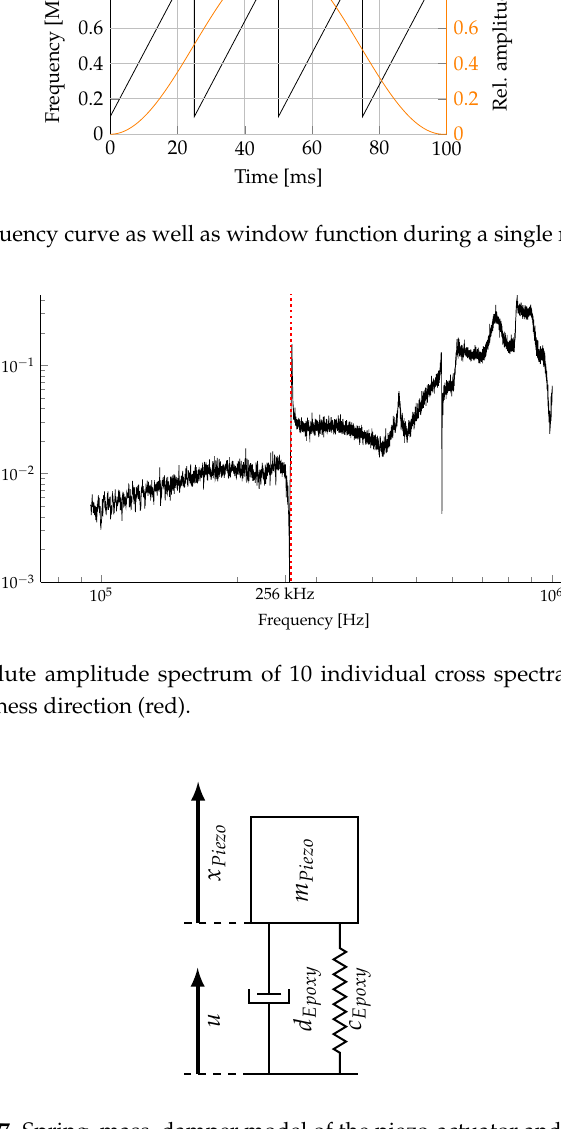
Figure 7. Spring–mass–damper model of the piezo-actuator and epoxy. The spring–mass–damper system has the parameters of Table 1. Table 1. Material parameters